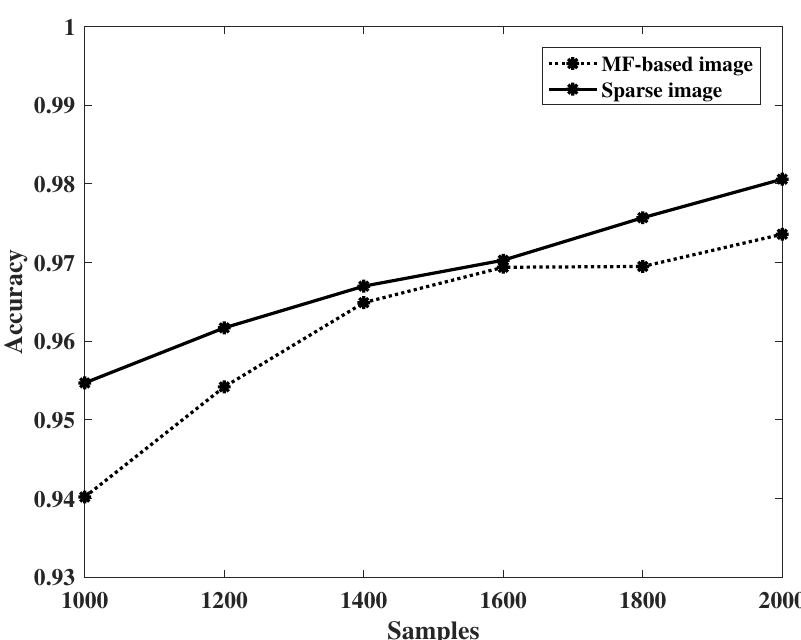
Figure 10. Experimental results based on different input datasets under SOC.